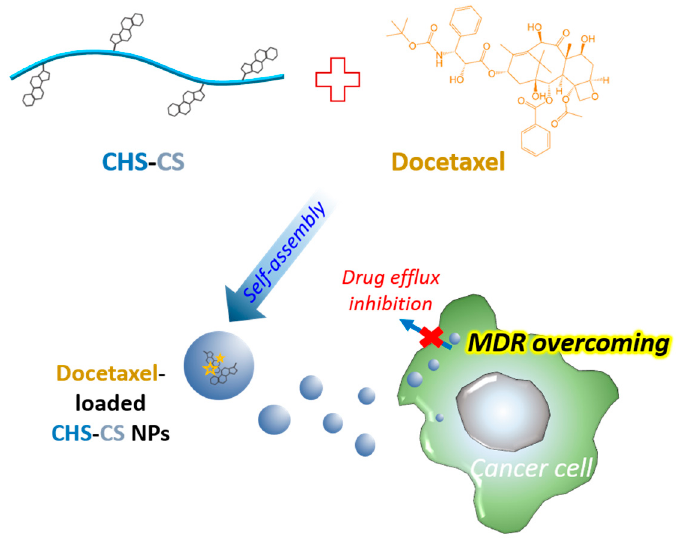
Figure 1. Schematic illustration of cholesteryl hemisuccinate-conjugated chitosan (CHS-CS) nanoparticles (NPs) and multidrug resistance (MDR)-overcoming in cancer cells.